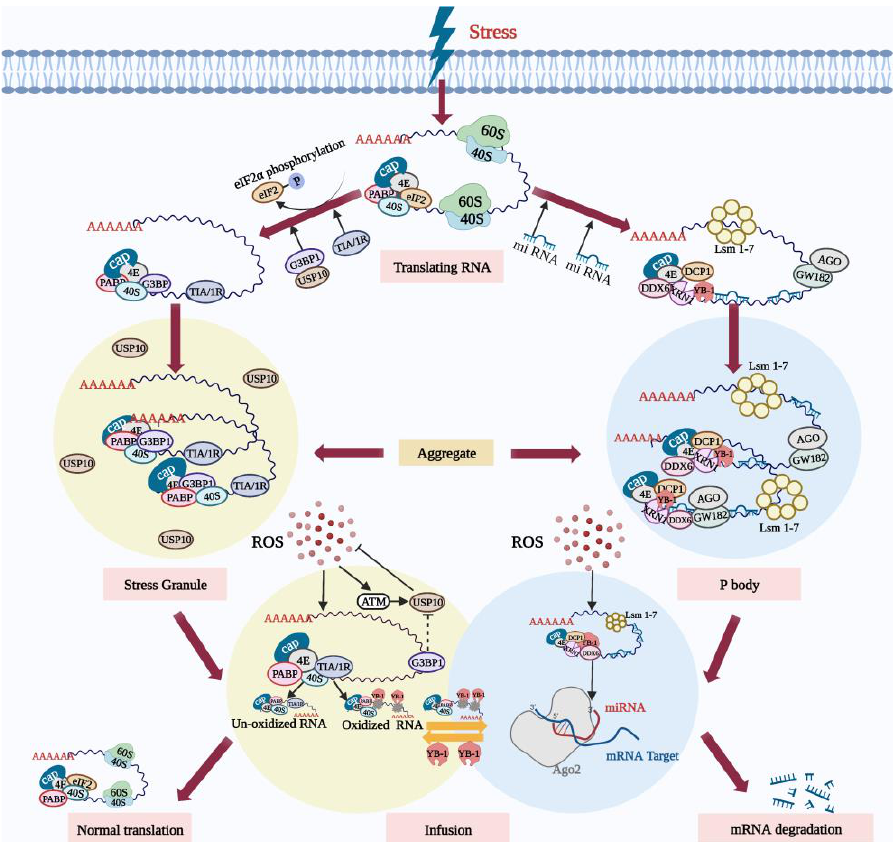
Figure 2. SGs and PBs actively participate in the degradation of oxidized RNA during oxidative stress. Following oxidative stress, the translation of some mRNA in cells is inhibited. On the one hand, the stress-induced phosphorylation of eIF2α inhibits translation initiation, and assembly of the stalled 48S initiation complex promotes the formation and aggregation of SGs. A large amount of RNA that has paused translation is sequestered in the SGs. SGs’ core component G3BP1 relieves the inhibition of USP10. ROS activates ATM and promotes the phosphorylation of USP10, triggering the antioxidant response. On the other hand, the stress-induced PBs mediate the RNA degradation. SGs and PBs dock, and RNA without oxidative damage can be re-translated under stress conditions. However, oxidized RNA is recognized by the YB-1 protein and transferred to PBs for degradation. Created with BioRender.com (accessed on 19 October 2022).